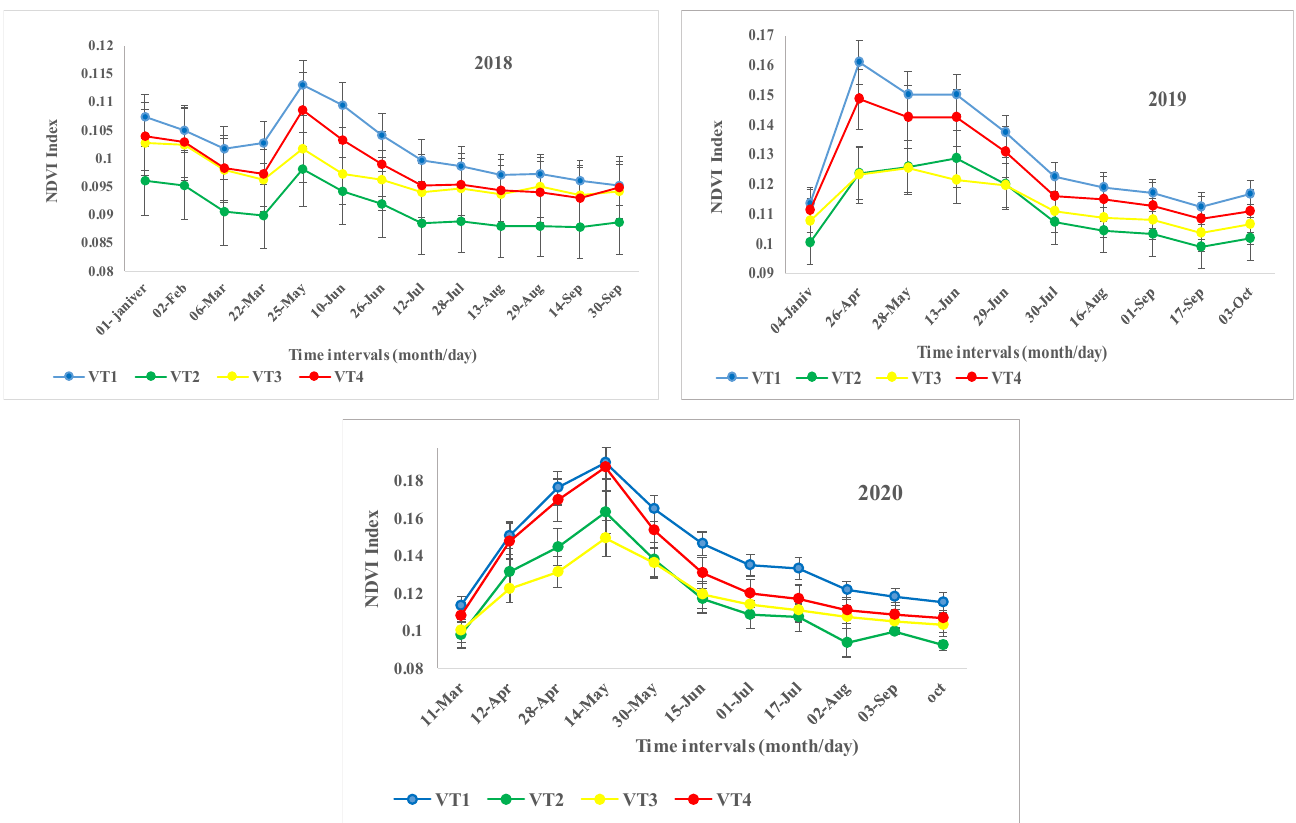
Figure 6. The NDVI temporal profile and error bars for each VT class for the years 2018–2020.